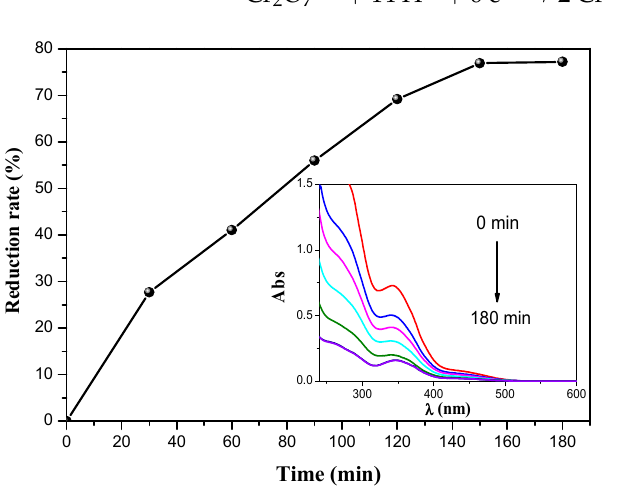
Figure 8. Reduction efficiency on Cr(VI) as a function of time; [Cr] 0 = 30 mg/L, catalyst dose 1 g/L; inset: UV–visible spectra.